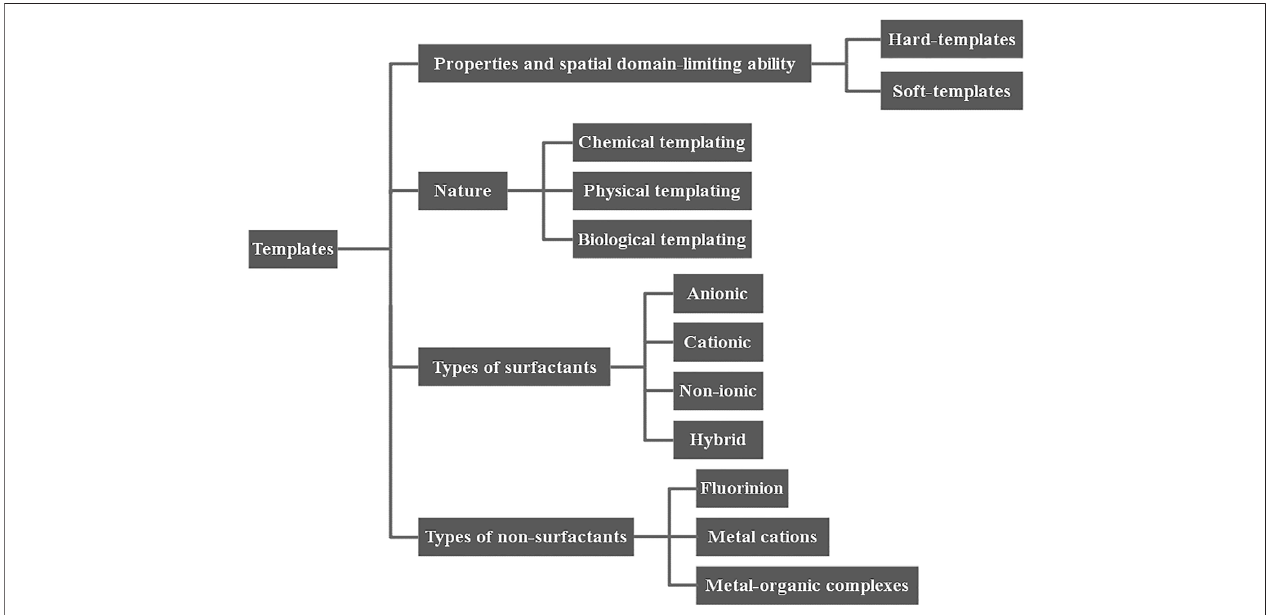
FIGURE 2 | Classi fi cations of